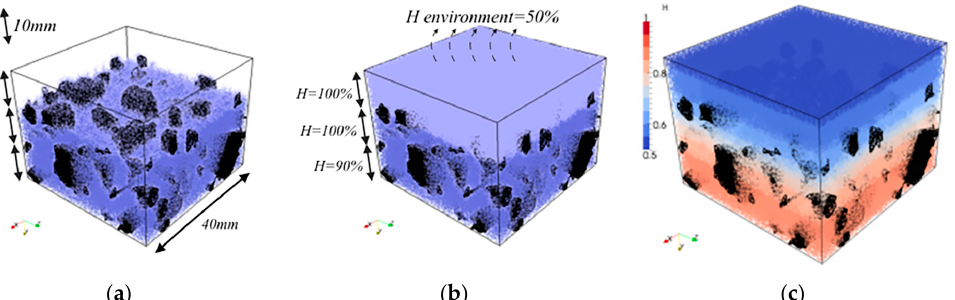
Figure 7. Lattice preparation procedure and moisture simulations ( a ) Imitating sandblasted surface (top 3 mm of aggregates is exposed); ( b ) “Casting” repair mortar with 10 mm thickness; ( c ) Moisture distribution in the repair system at 110 days of drying.